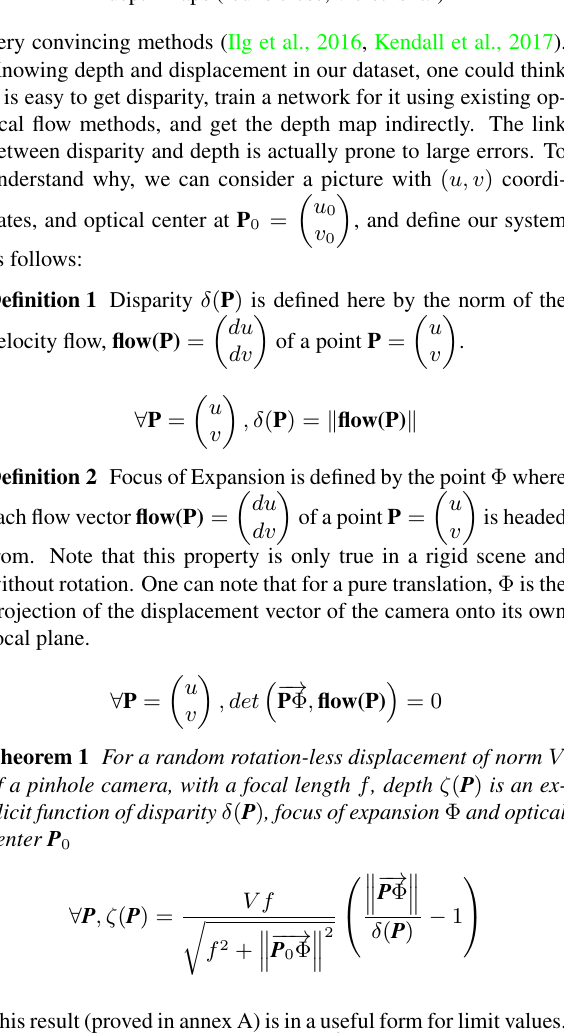
Figure 2. Some examples of our renderings with associated depth maps (red is close, violet is